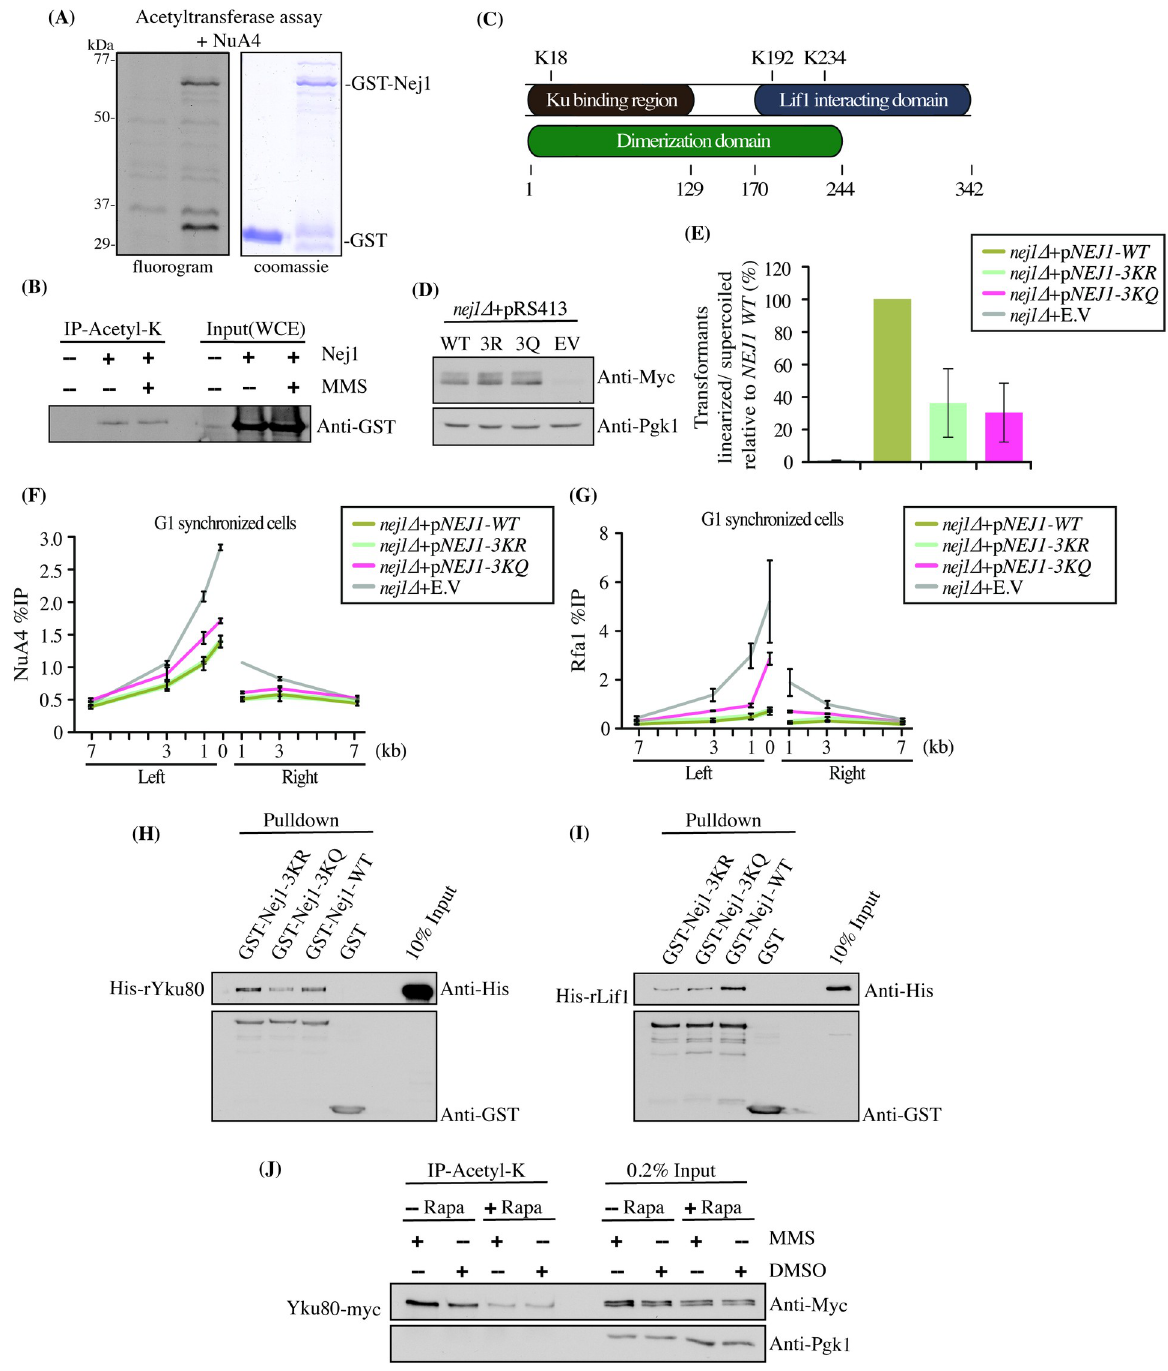
Fig 6. NuA4 inhibits NHEJ through acetylation of Nej1. (A) in vitro acetylation assay using purified NuA4 complex and recombinant GST-Nej1. After the reaction with radioactive acetyl-CoA, the reactions were loaded on gel, processed for fluorography/exposed on film. The GST-Nej1 protein is clearly acetylated by NuA4 in vitro .GST alone is used as negative control. Faint labeled bands in both samples correspond to known auto-acetylation of NuA4 subunits (e.g. Yng2 at 36kDa [17]). (B) Nej1 is acetylated in vivo . Anti-acetyl-lysine immunoprecipitations were performed on extracts from cells over-expressing GST-NEJ1 from a multicopy vector. Nej1 Acetylation level is detected by anti-GST western on the immunoprecipitated material. (C) Drawing showing the locations of the acetylated residues identified by mass spectrometry that were not present in the esa1-ts sample (see also S6A Fig and S2 Table for full list of identified acetylated peptides). Known functional domains of Nej1 are also indicated. (D) Western blot on whole cell extracts comparing native wild type and mutant Nej1 expression levels in constructed strains used in (E). (E) nej1-3KR and nej1-3KQ mutant cells show reduced plasmid re-ligation efficiency for EcoR1 linearized pSO98 plasmid. Samples